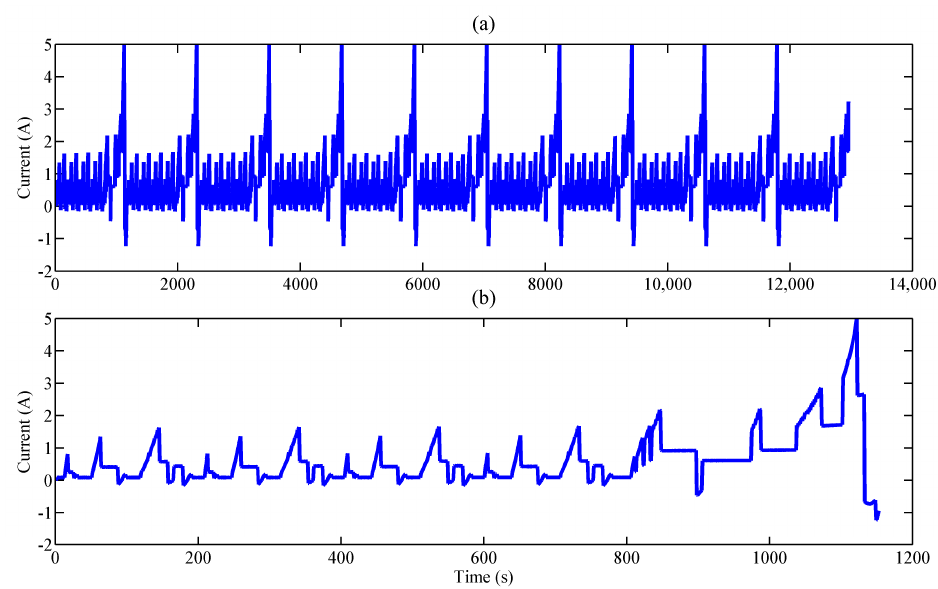
Figure 5. ( a ) Discharge current of a complete New Europe Driving Test (NEDC) test; ( b ) A cycle of the